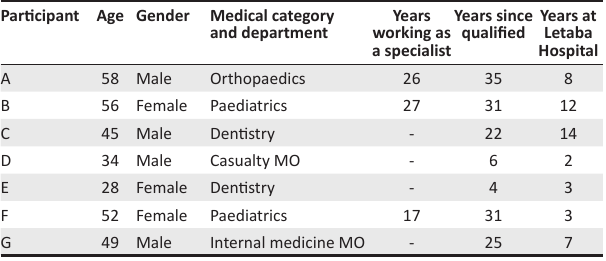
TABLE 1: Baseline characteristics of